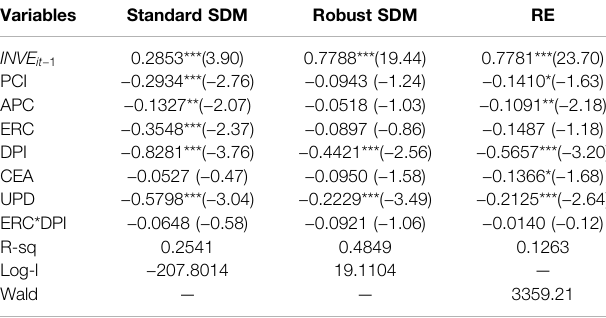
TABLE 10 | Robustness tests (INVE1).